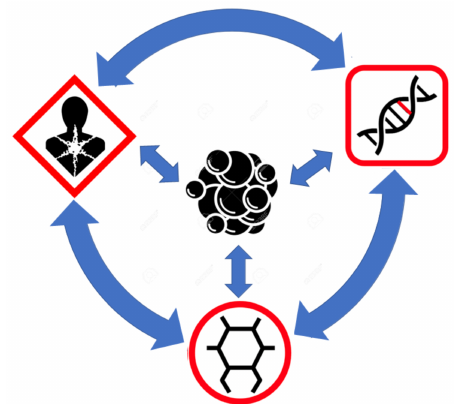
Figure 2. An interconnected, multi-omics view of cancer. In this view the exposome, the genome, and the metabolome all contribute individually to the development of cancer (arrows pointing